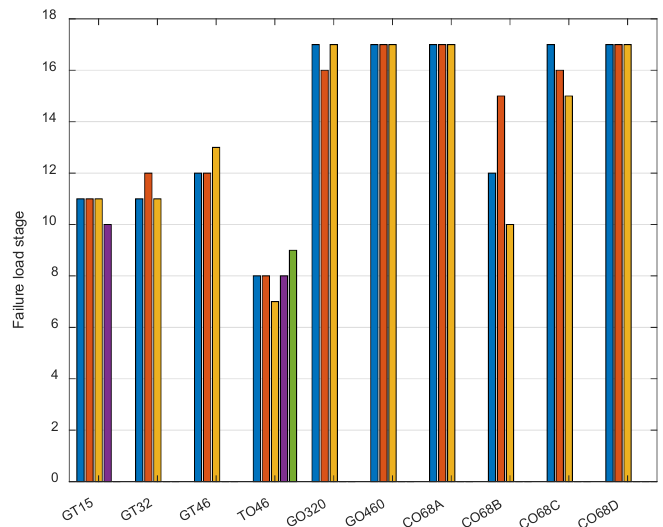
Figure 4. Repeatability of the experimental results.